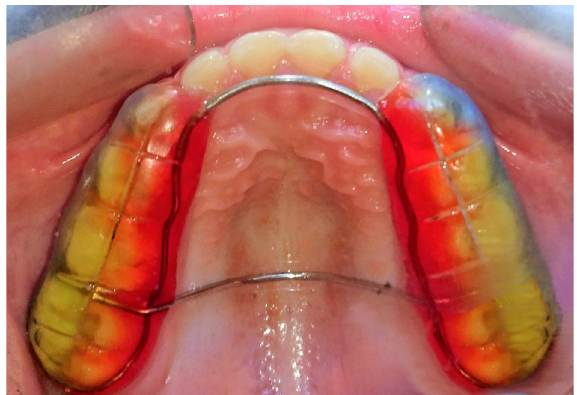
Figure 2. The bonded maxillary bite block used intra-orally in conjunction with the chincup